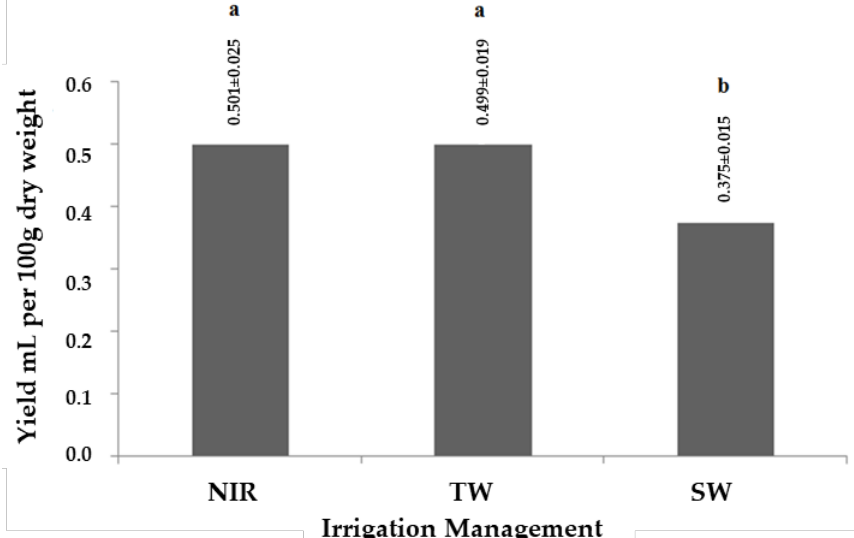
Figure 2. Variation of essential oil yields according to the three applied irrigagtion management. (SW: irrigated with salt water; NIR: not irrigated; TW: irrigated with tap water).